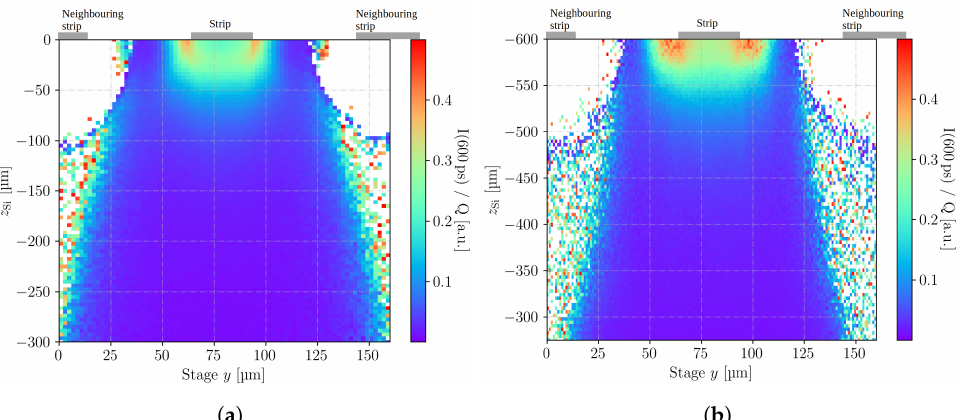
Figure 8. Weighted prompt current of yz -scans across the readout strip of the standard strip detector at 50V, obtained with illumination from the back side ( a ) and the top side ( b ). Figure ( b ) only shows the mirror image and not the non-reflected image, to ease the comparison with figure ( a ). Note that the z Si -axis of figure ( b ) is slightly larger compared to figure ( a ) to compensate for the decreasing numerical aperture due to clipping. The strip metallisations are indicated by the grey boxes and note the different scale of z Si